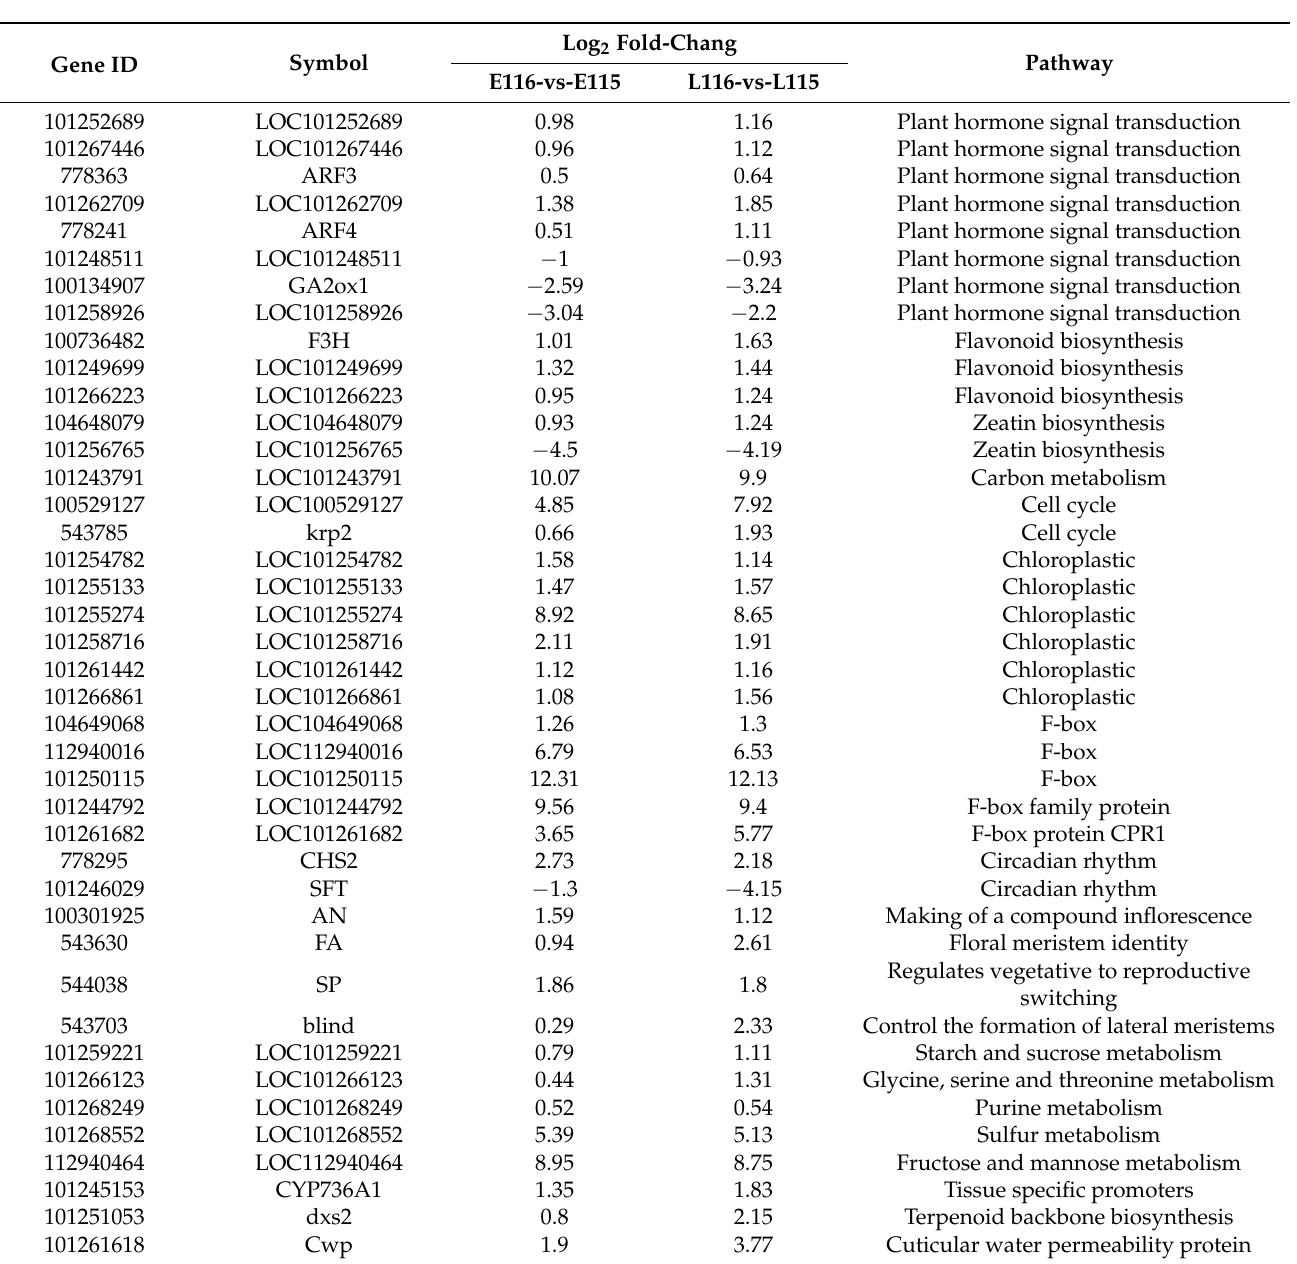
Table 2. Affect-related genes of tomato inflorescence